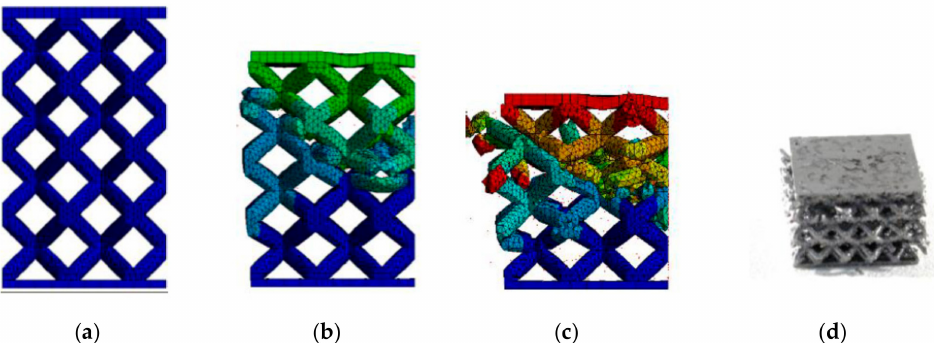
Figure 14. Gradual deformation of the specimen with elliptical strut cross-section in tim: ( a ) 0 ms; ( b ) 1.31 ms, ( c ) 3.78 ms; and ( d ) real damage of the specimen IT-2 after low-velocity impact